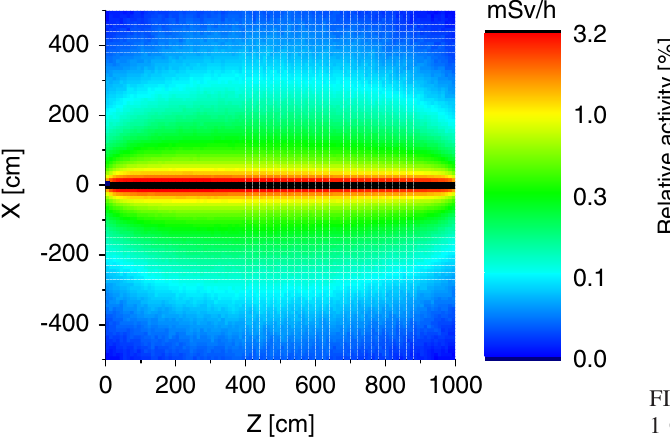
FIG. 2. (Color) Effective-dose rate map in the vicinity of the beam pipe in the horizontal XZ plane ( Y ¼ 0 cm ).